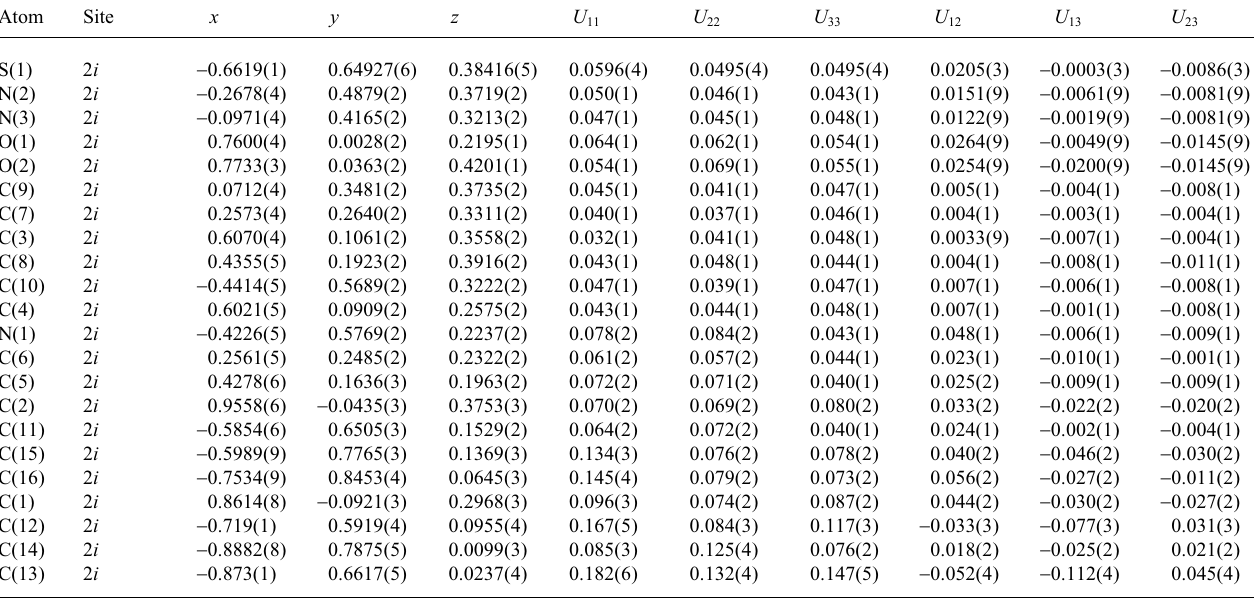
Table 3. Atomic coordinates and displacement parameters (in Å 2 )